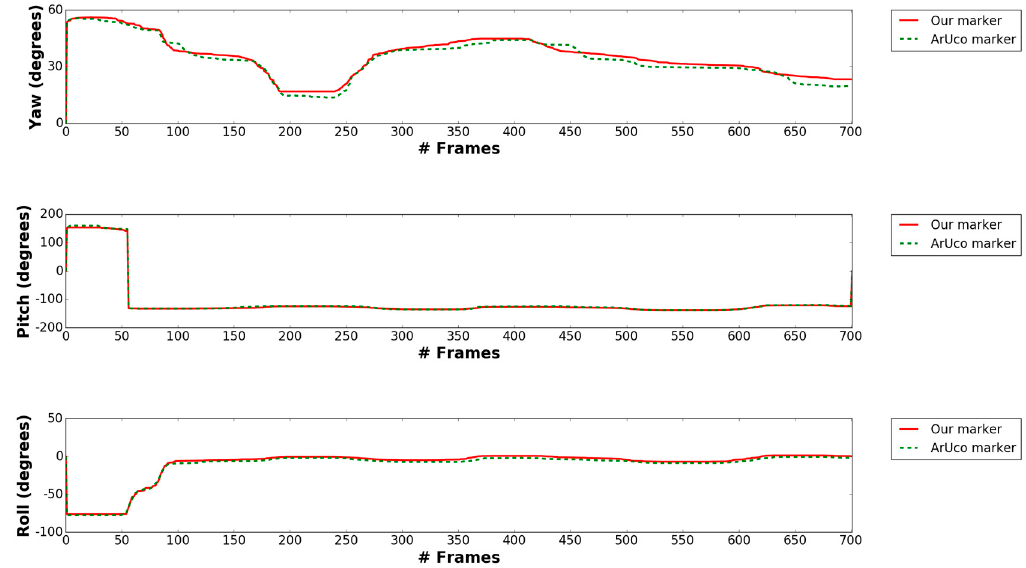
Figure 20. Comparison between estimated yaw, pitch, roll rotations of our marker and ArUco marker. Table 7. Average error of pose estimation in a free flying case scenario.